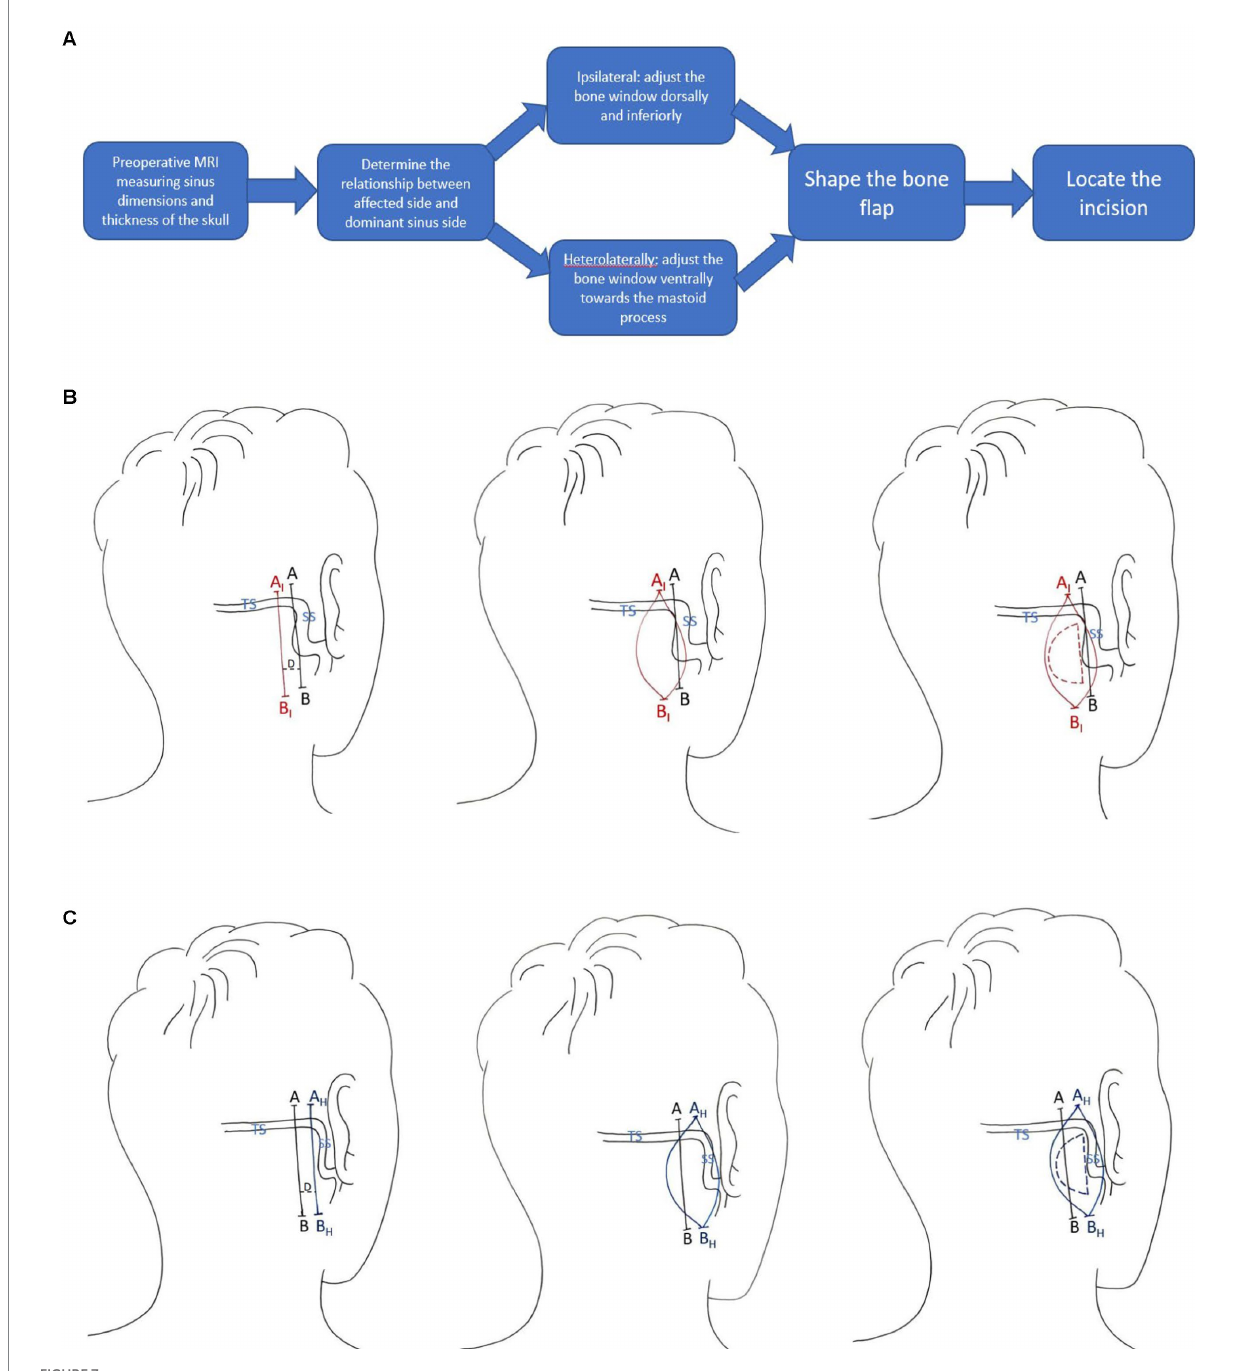
FIGURE 7 (A) Procedure of the improved approach. (B) Adaption for ipsilateral cases. Line AB is the conventional drawing and A I B I is the improved drawing. The distance D between line AB and A I B I should be determined from sigmoid sinus dimensions by case as measured from preoperative MRI. (C) Adaption for heterolateral cases. Line AB is the conventional drawing and A H B H is the improved drawing. The distance D between line AB and A H B H should be determined from sigmoid sinus dimensions by case as measured from preoperative